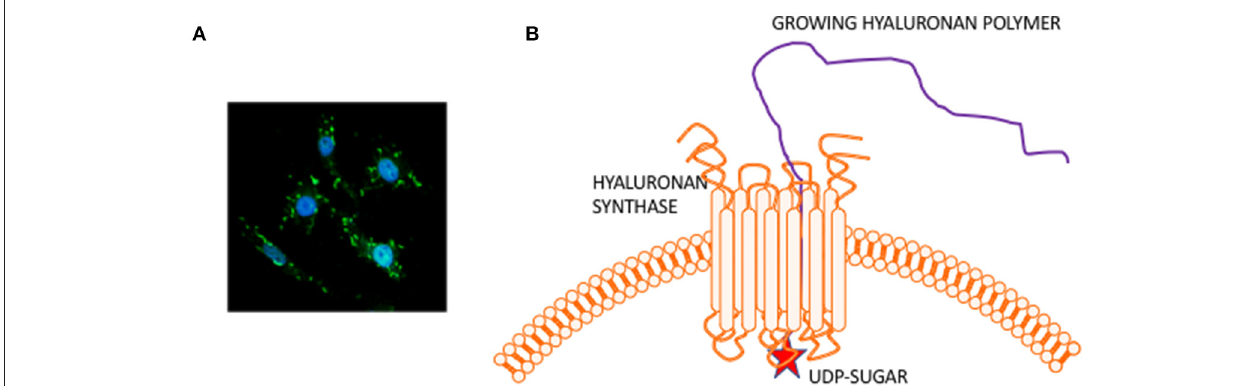
FIGURE 2 | Hyaluronan is a simple polysaccharide produced by cell membrane synthases. (A) Micrograph showing membrane localized hyaluronan synthase 2 in fibroblasts. (B) Hyaluronan synthase has multiple transmembrane domains that cluster to form pores in the cell membrane. UDP-sugars bind to the protein cytoplasmic face and growing polymer is extruded through the pore to the extracellular